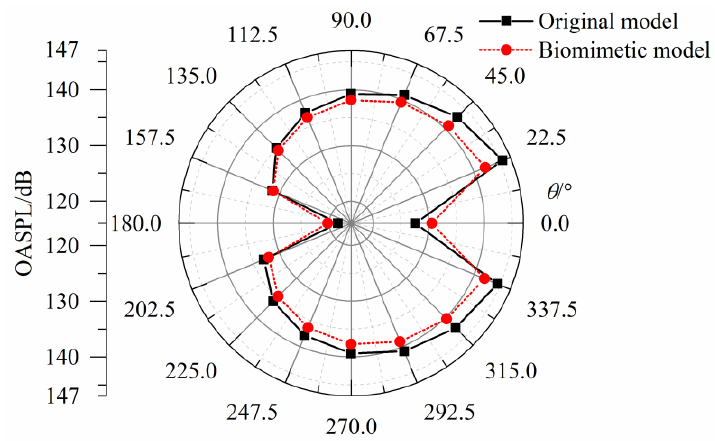
Figure 15. Comparison of the predicted overall sound pressure levels (OASPLs) of the original hydrofoil and biomimetic hydrofoil at the 16 observing points of the near sound field.